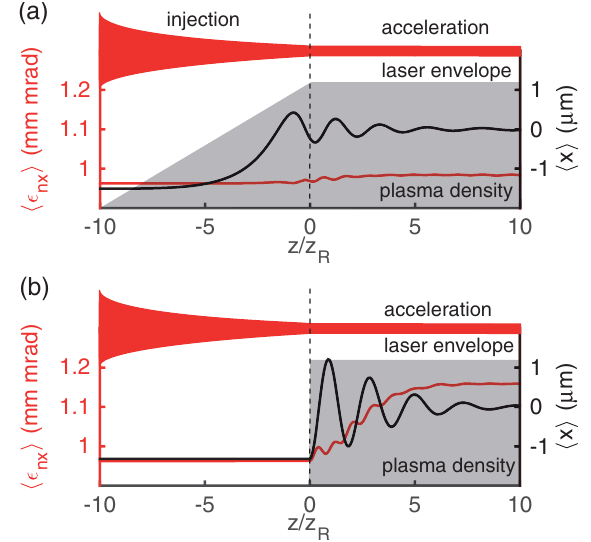
FIG. 3. A proper matching into the acceleration section of the plasma relaxes the tolerances to beam position jitter. The emittance (red line) is averaged over 3000 independent runs, with a laser and bunch position jitter of 10% rms of their respective spot size at the focus. Gray and red areas indicate the plasma density profile and laser envelope, respectively. The emittance effectively stays constant when including the matching section (a), while it increases by about 20% if the laser and electron beam are directly focused to the entrance of the acceleration channel (b). The exemplary trajectory of a bunch initially displaced by 1 σ of the position jitter is shown in black. The matching section reduces the oscillation amplitude at the laser focus and therefore the emittance